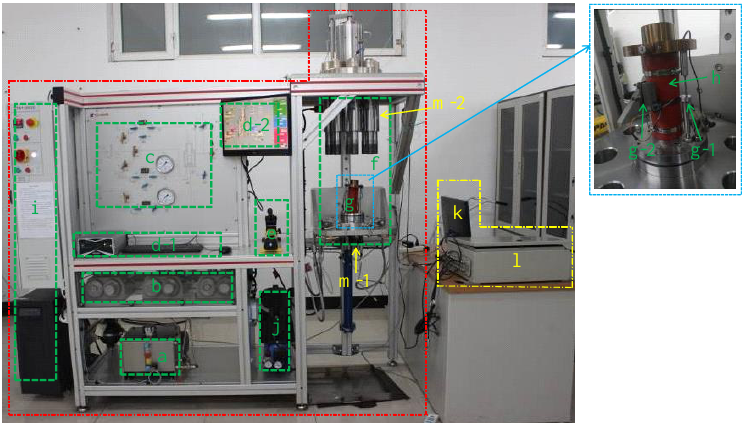
Figure 2. Experimental site. (a, b, e, f, g, j-loading system; c, d, i-control system; h-sample; k, l, m-acoustic emission system).